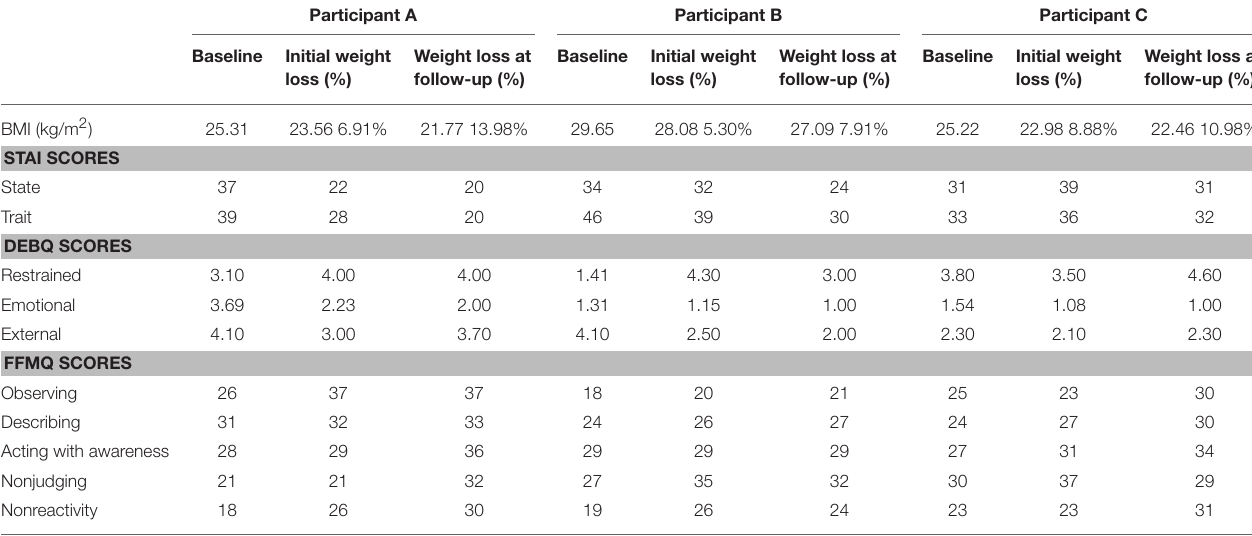
TABLE 2 | Changes to weight and psychological health before, during, and after treatment. Participant A Participant B Participant C Baseline Initial weight Weight loss at Baseline Initial weight Weight loss at Baseline Initial weight Weight loss at loss (%) follow-up (%) loss (%) follow-up (%) loss (%) follow-up